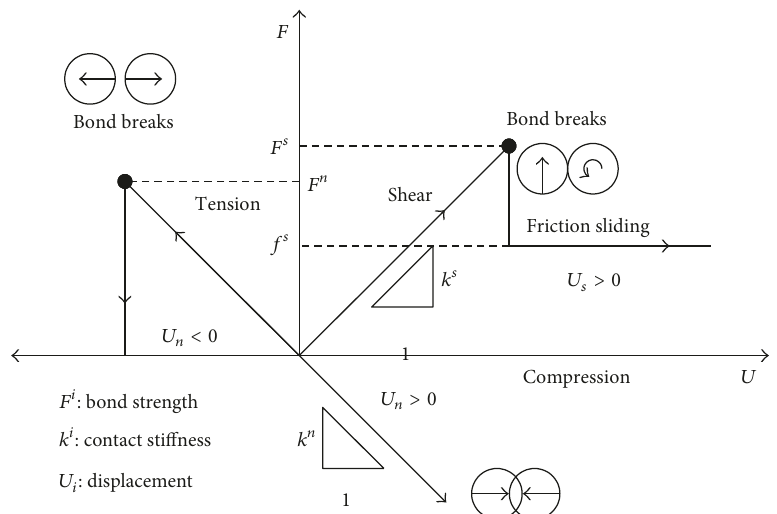
Figure 2: Illustration of the yield process for a parallel bond.